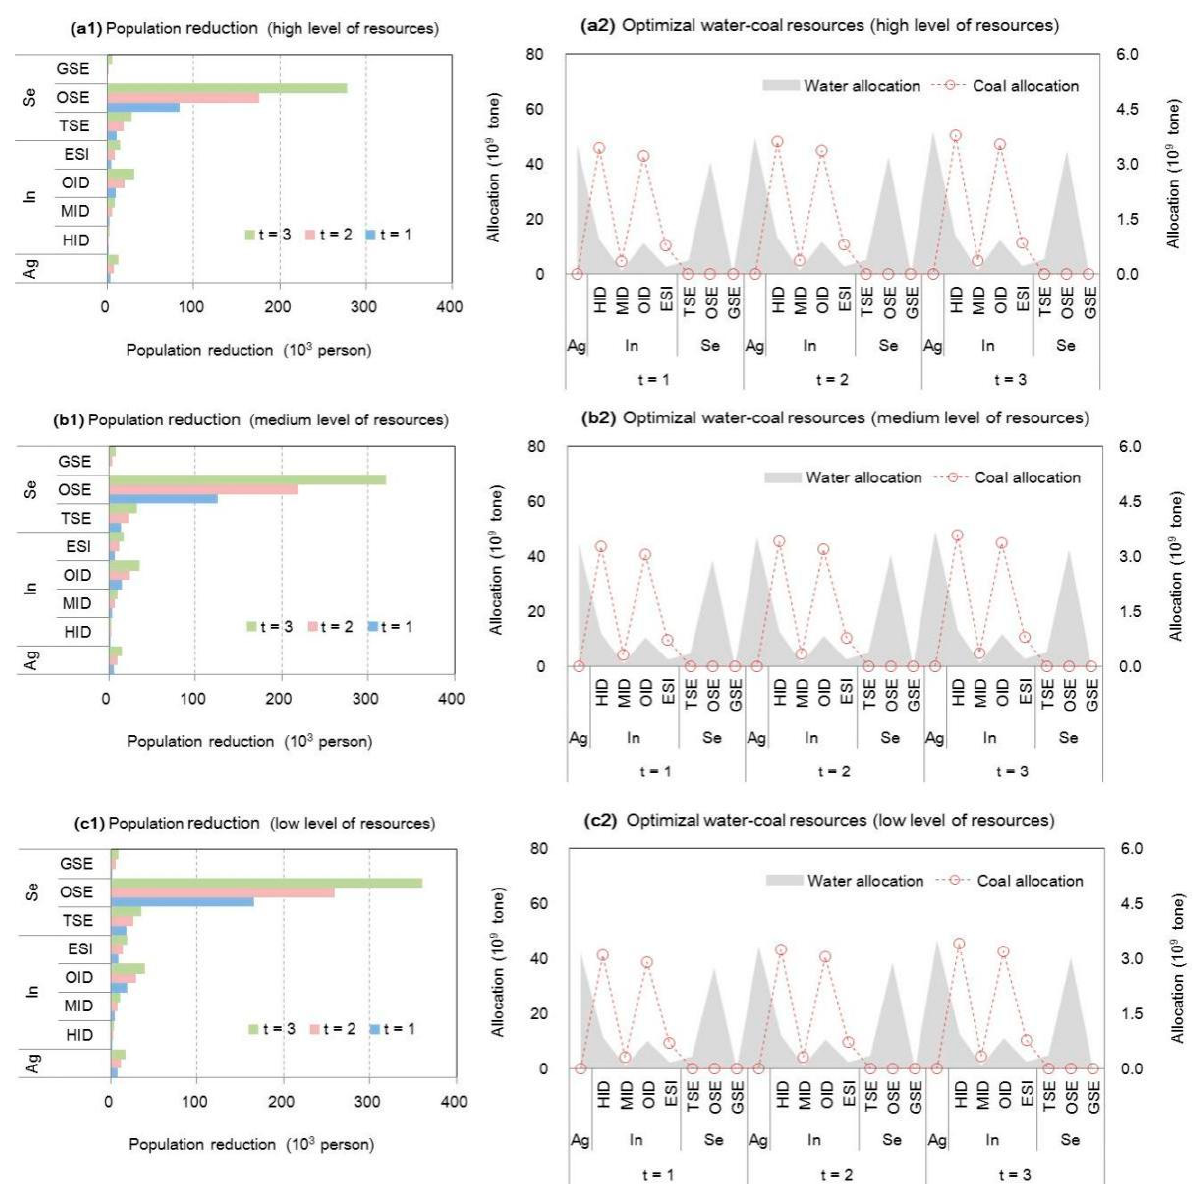
Figure 4. Population adjustments among different industrial plants based on water–coal optimization under S0 when α = 0.99 and β = 0.6 (agricultural sector denoted as “Ag”, industrial sector denoted as “In”, service sector denoted as “Se”, municipal sector denoted as “Mu”; heavy-consumption industry plant denoted as “HID”, medium-consumption industry plant denoted as “MID”, other industry plant denoted as “OID”, energy-supply industry plant denoted as “ESI”, traditional service industry plant denoted as “TSE”, other service industry plant denoted as “OSE”, environmental protection industry plant denoted as “GSE”, urban municipal consumption plant denoted as “URB”, rural consumption plant denoted as “RUR”) (( a1 , a2 ) are population adjustment and corresponding optimized water-coal resources under high level of resources; ( b1 , b2 ) are population adjustment and corresponding optimized water-coal resources under medium level of resources; ( c1 , c2 ) are population adjustment and corresponding optimized water-coal resources under low level of resources)